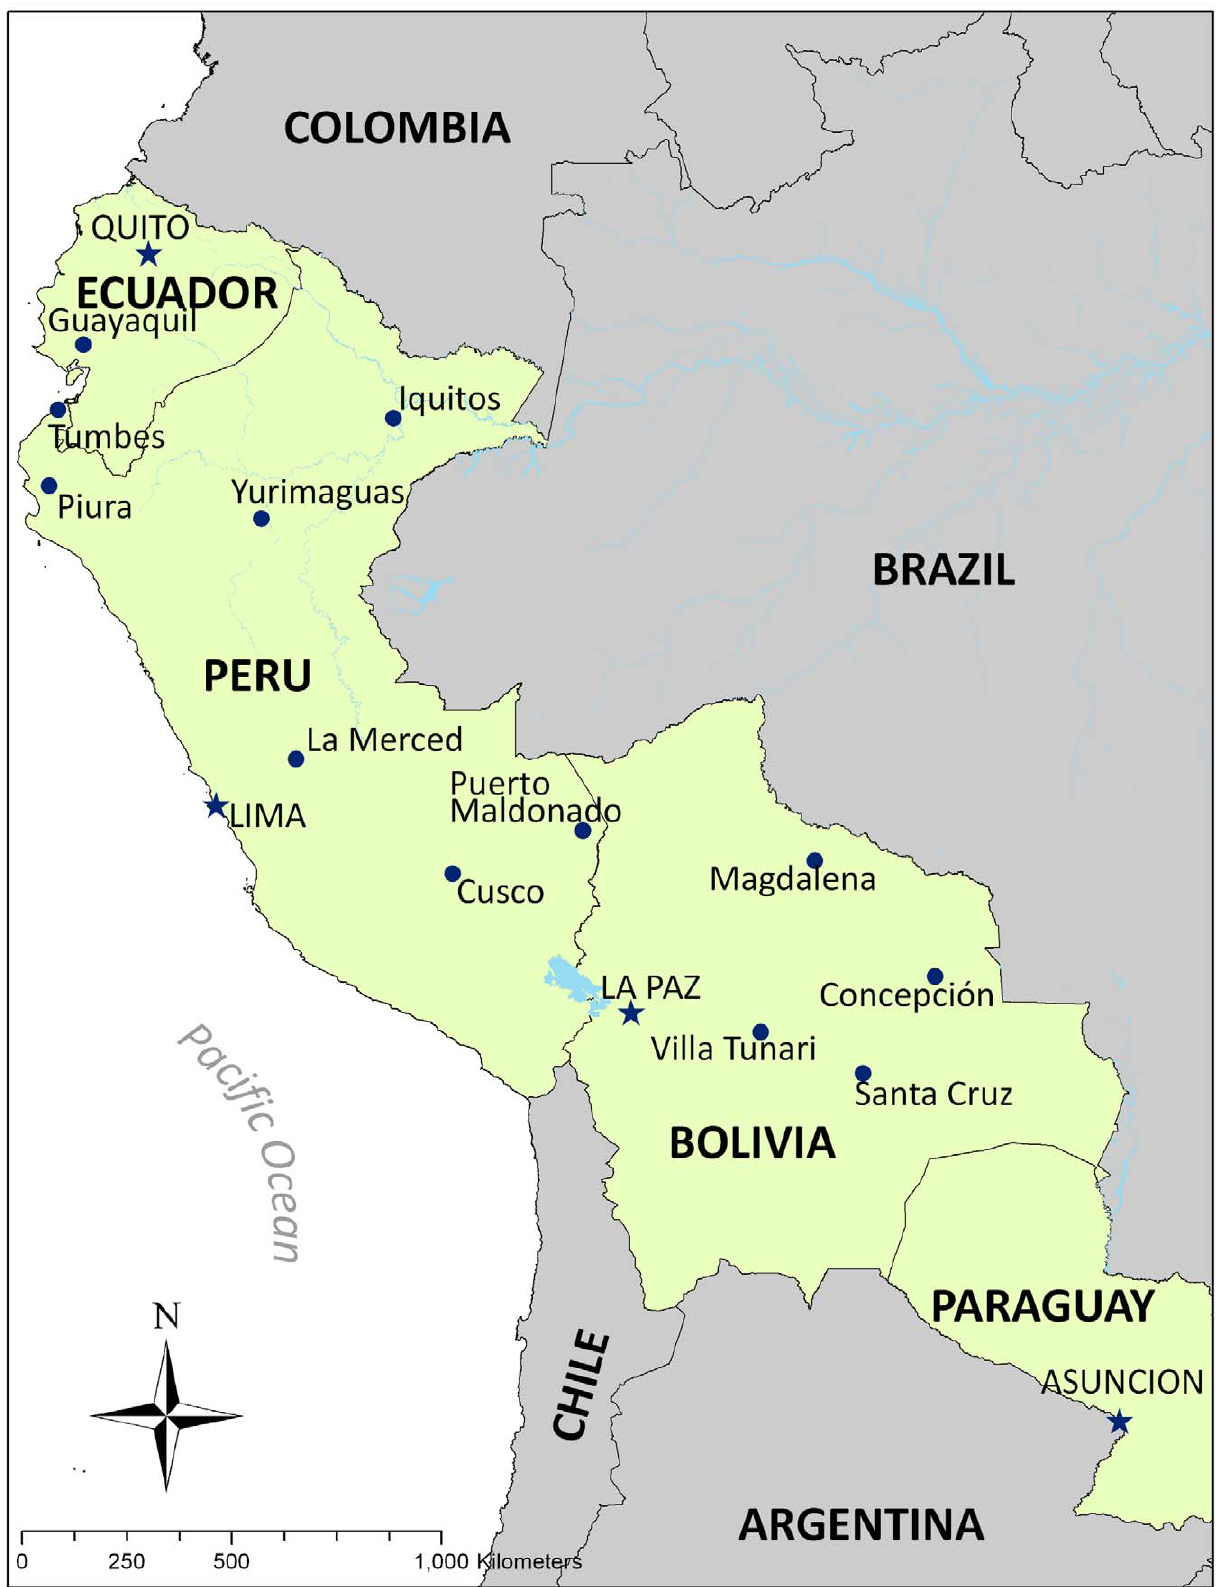
Figure 1. Map of study sites in Ecuador, Peru, Bolivia, and Paraguay. Capitals of Ecuador (Quito), Peru (Lima), and Bolivia (La Paz) are shown for reference.